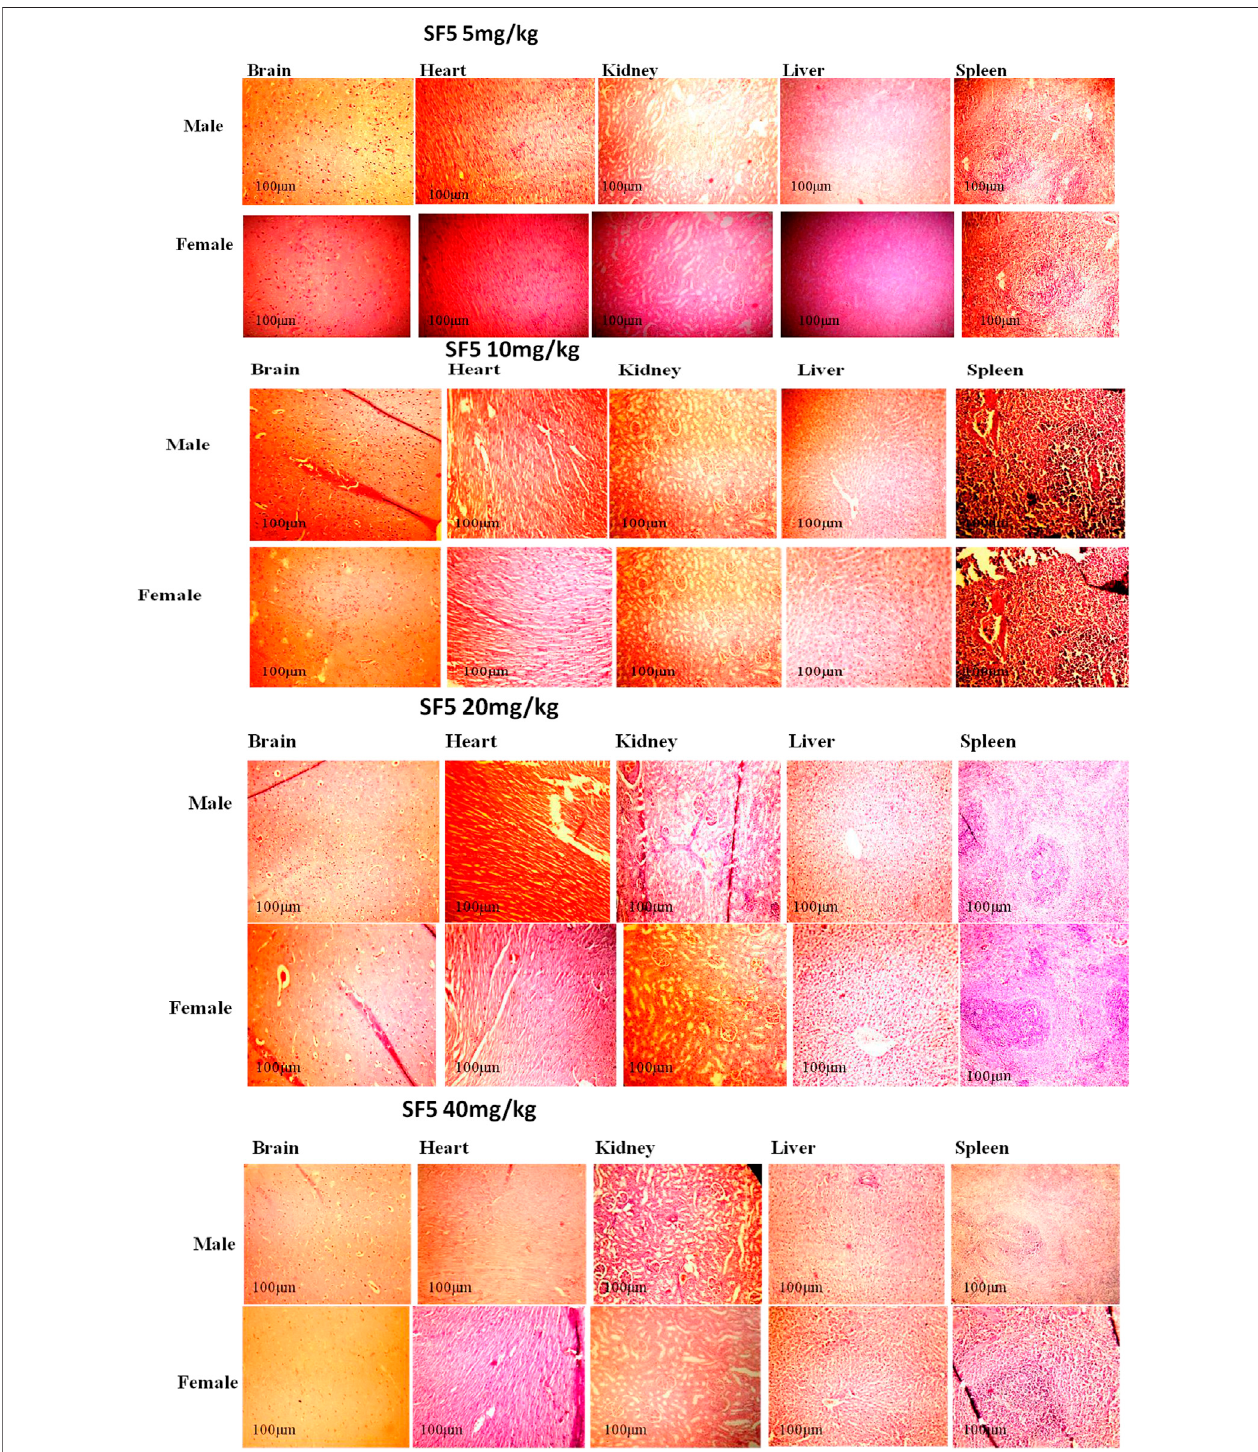
FIGURE 8 | Histopathological analysis of different organs in subacute toxicity studies of SF5 at 5, 10, 20, and 40 mg/kg dose levels.